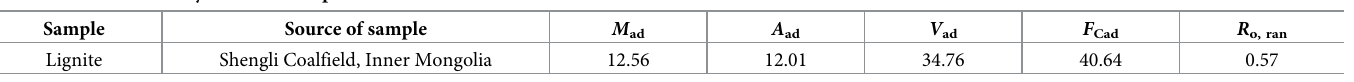
Table 1. Proximate analysis of coal sample.